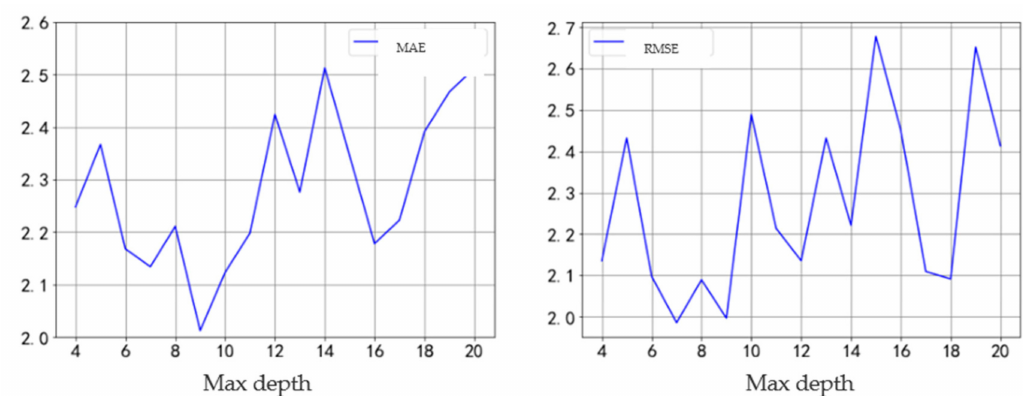
Figure 9. Model iteration error.